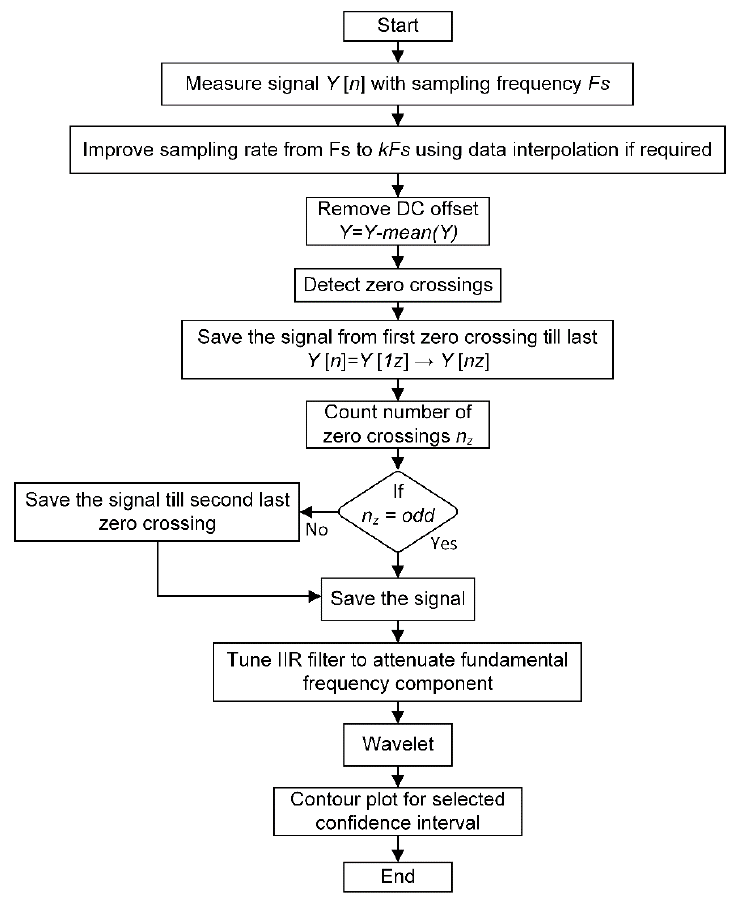
Figure 2. Flowchart for better frequency resolution and development of contour plot.